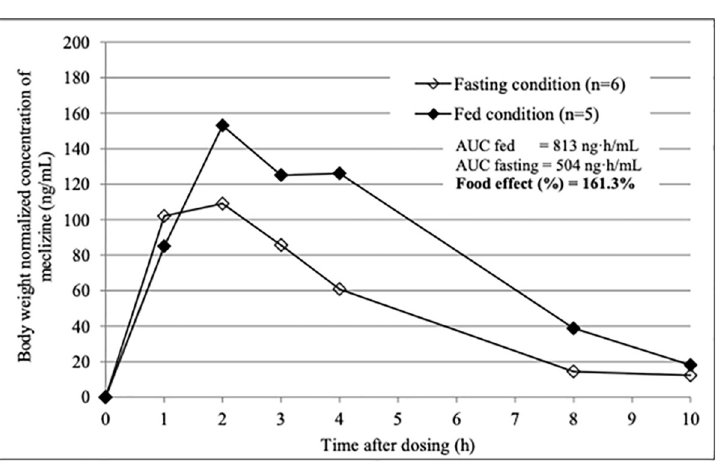
Fig 6. Body weight normalized plasma concentration of meclizine in the fasting and fed condition. The AUC 0-10h of the fasted and fed condition were 504 ng � h/mL and 813 ng � h/mL,